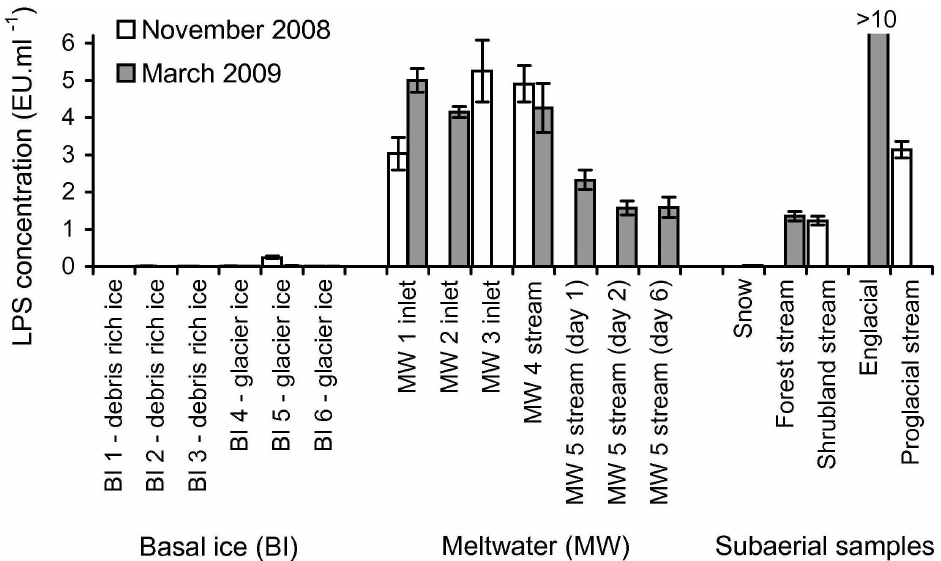
Figure 4. Determination of LPS levels in 27 glacial samples using the rFC assay. Details of the sampling sites are described in Section 2.3. All assays were performed with no significant sample processing (minimal processing protocol). LPS concentration was quantified by using the daily LPS calibration sets, assuming a linear interpolation from a log-log plot of LPS standards (10, 1 and 0.1 EU · mL − 1 ) and the assay responses. The y -axis (LPS concentration) has been truncated ( i.e. , the value for 2009 englacial water is clipped) to enable better visualisation of the relationship of the LPS concentration values of the other samples. Error bars are ± 1 SD of assay responses from